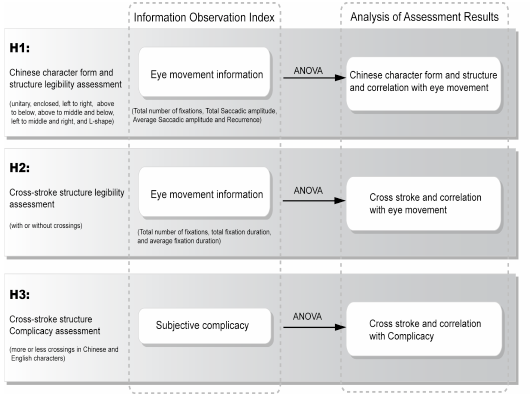
Figure 2. Research framework of Chinese character